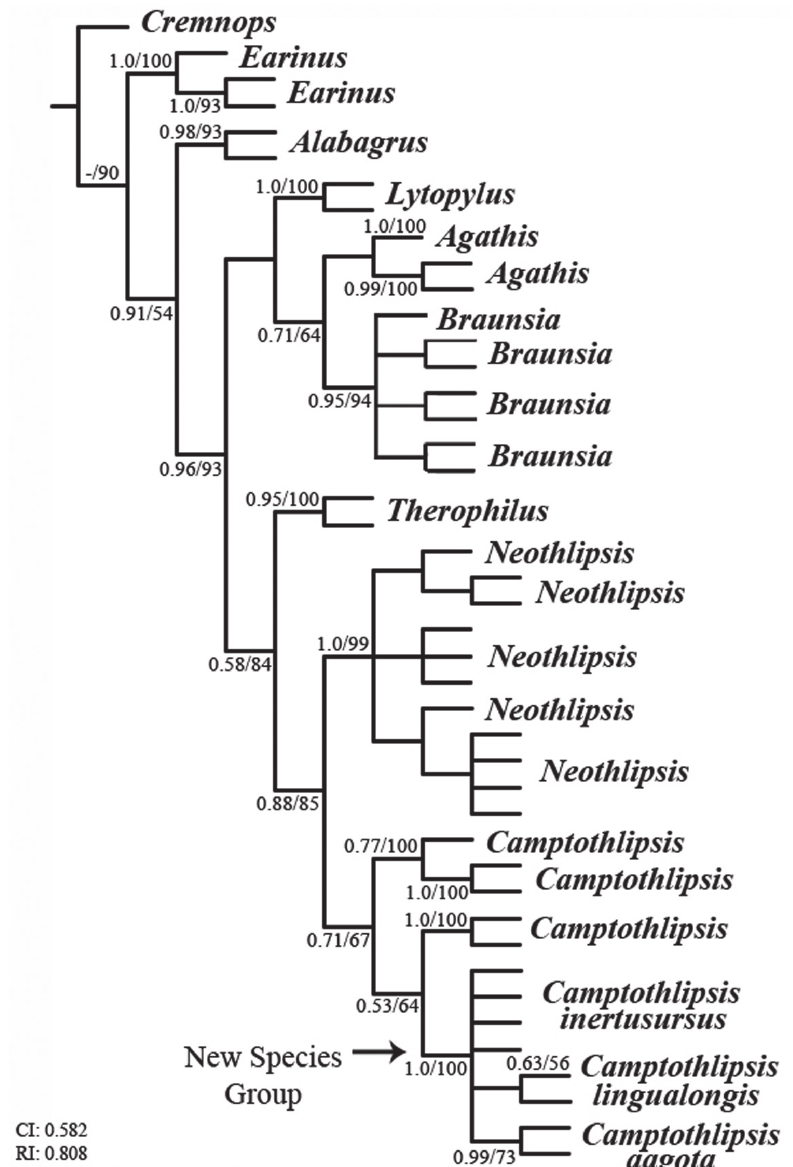
Figure 2. A partial maximum parsimony cladogram of the subfamily Agathidinae. Consistency ( CI ) and retention ( RI ) index values are given at bottom left; branch support values are posterior probabilities/ bootstrap